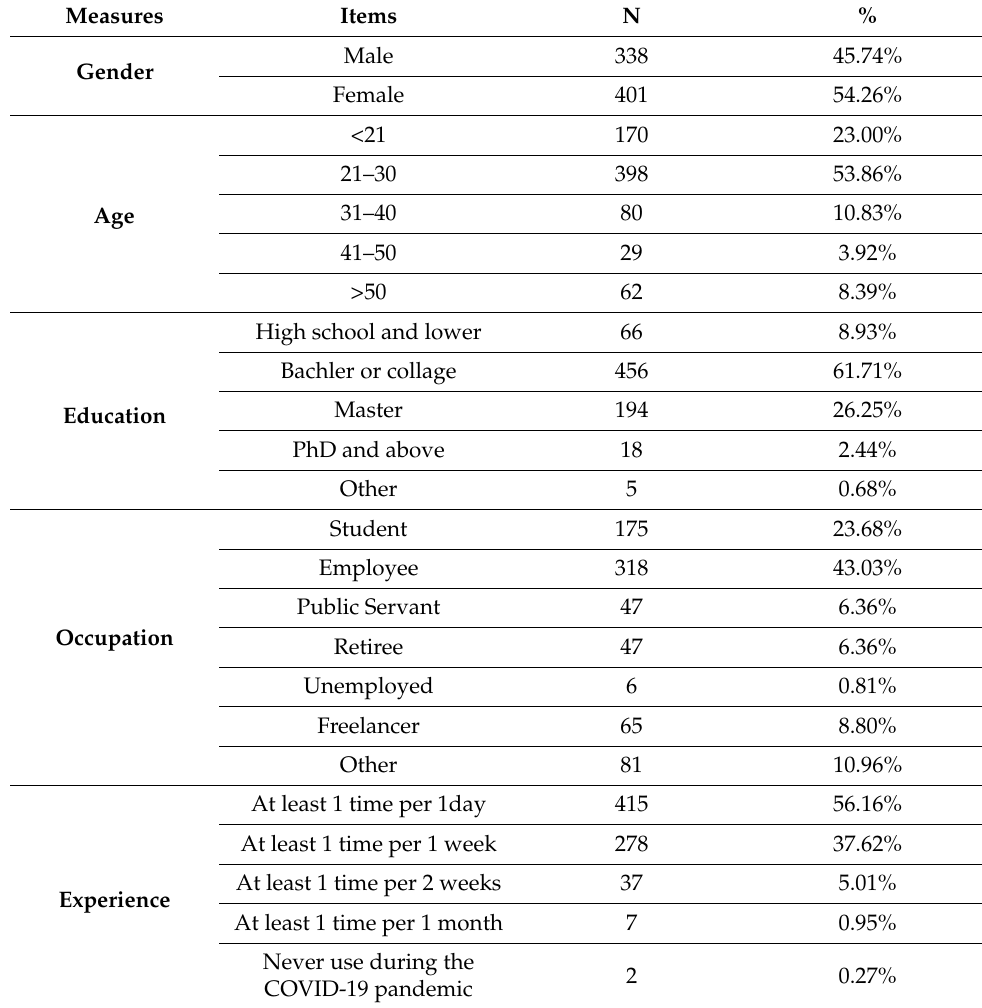
Table 2. Demographic distribution of the